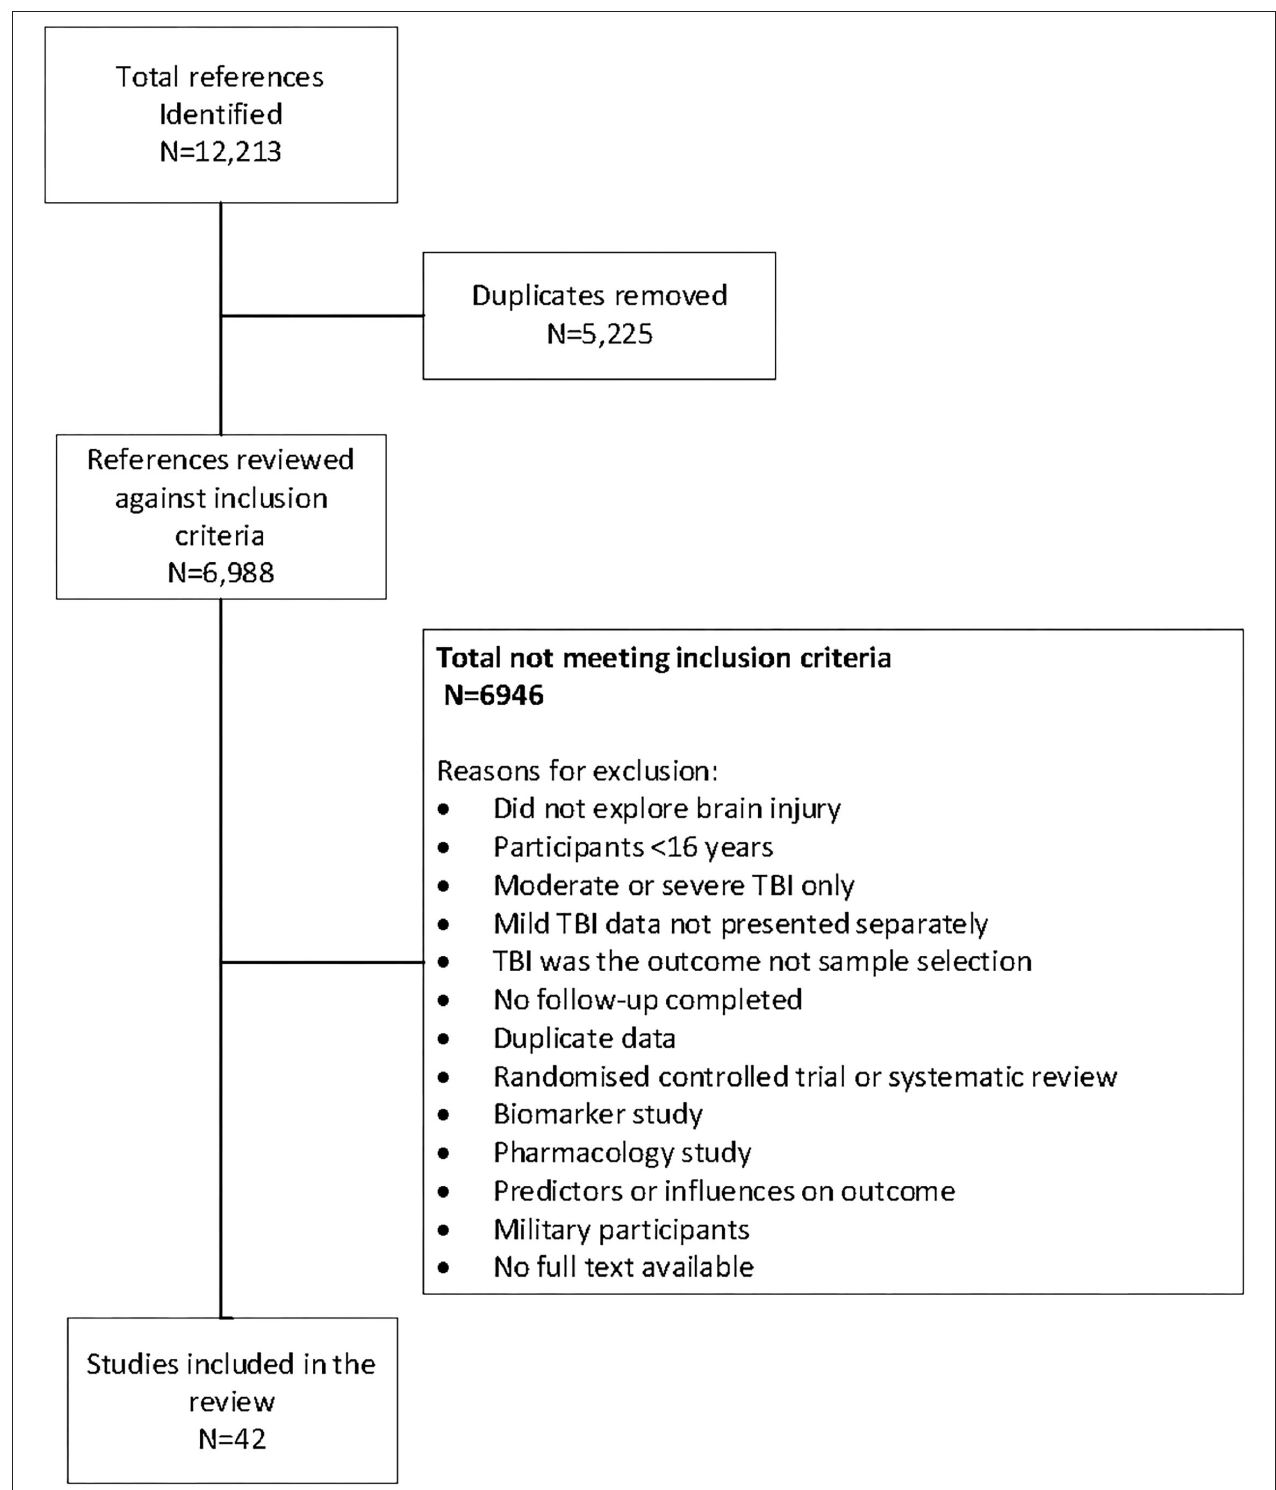
FIGURE 1 | The study selection